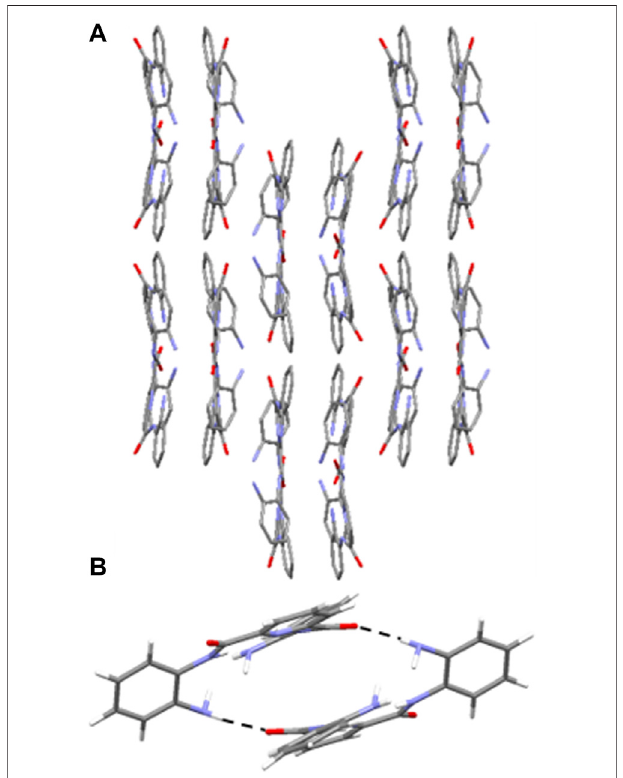
FIGURE 5 | (A) Crystal packing of 3 as viewed along the c axis, highlighting the cofacial and slipped layered arrangement. Hydrogen atoms havebeenomittedforclarity. (B) Hydrogen-bondeddimerof 3 observedinthe solid state through reciprocal intermolecular N-H / O (cid:1) C hydrogen bonding interactions from the terminal amine NH and the amide O of an adjacentmolecule.Hatomsareshowninwhite,Cingrey,NinlightblueandO in red. Hydrogen-bonding interactions are shown as dashed black lines.